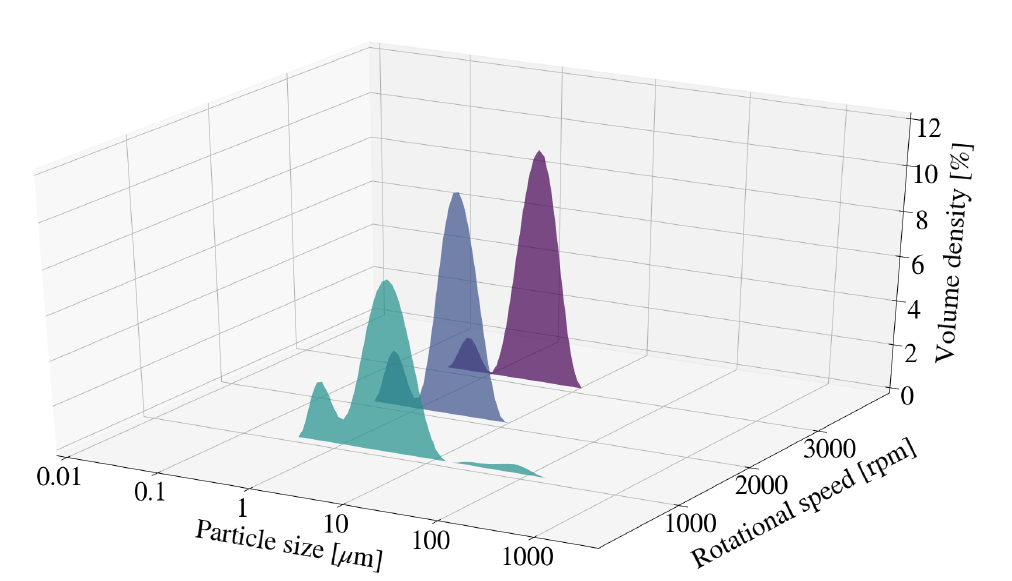
Figure 1. Particle size distribution for Mg-Al LDH samples synthesised at a cooling water inlet temperature of 30 °C, with a change in rotational speed (S1, S2, S3).